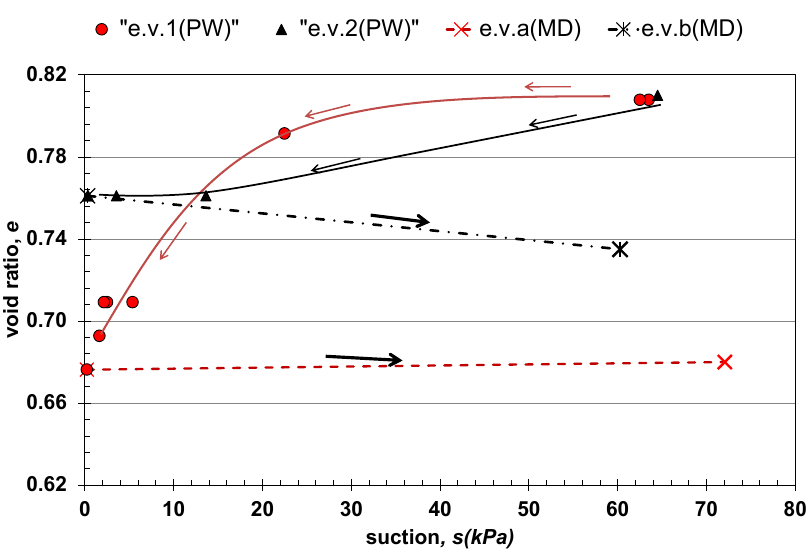
Figure 12. Reduction of void ratio, recorded by means of the experimental device for two specimens (e.v.1; e.v.2) subjected to a cycle of wetting (left arrows) and drying (right arrows). The e.v.1(PW) and e.v.2(PW) refer to the specimens wetted until the suction was